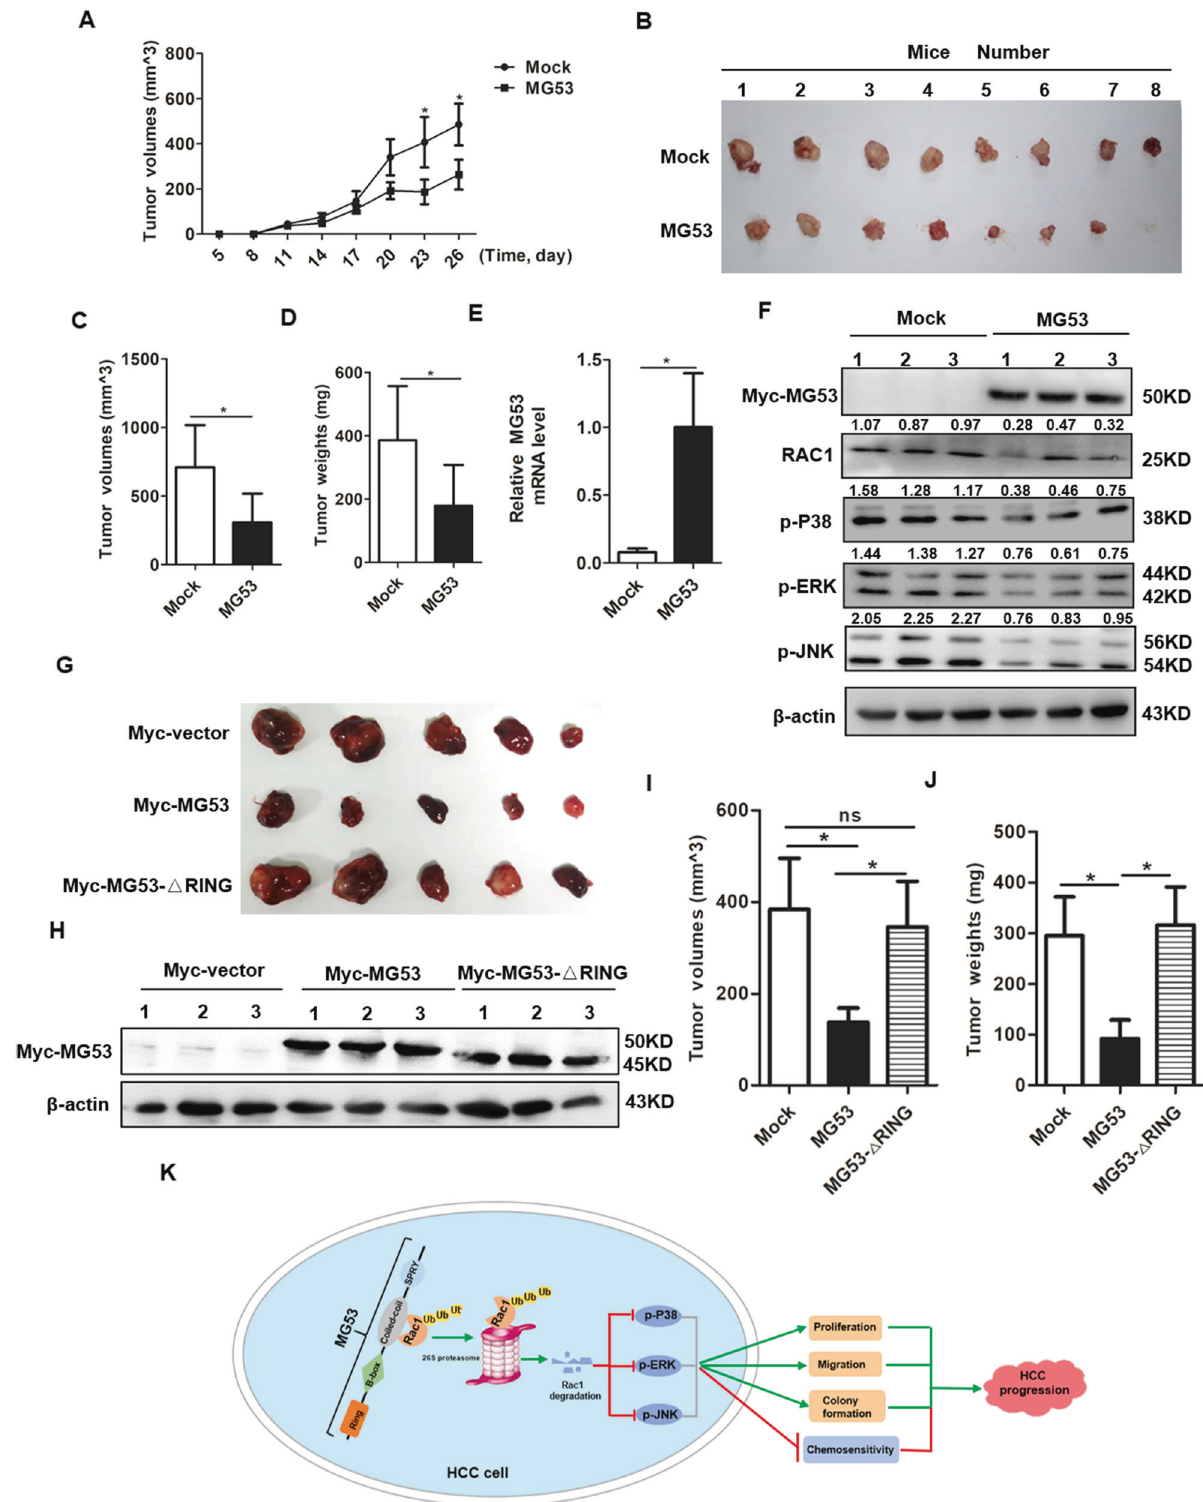
Xenograft tumor model 4-week-old male BALB/c nude mice were used for the construction of xenografted tumor model in our investigation, and the xenograft tumor model in nude mice was constructed as described before [48]. When visible tumors appeared, the tumors at the left fl anks were injected with 20 μ g Myc-MG53 plasmid while tumors at the right fl anks were injected with 20 μ g Myc-vector plasmid before the mice were sacri fi ced on day